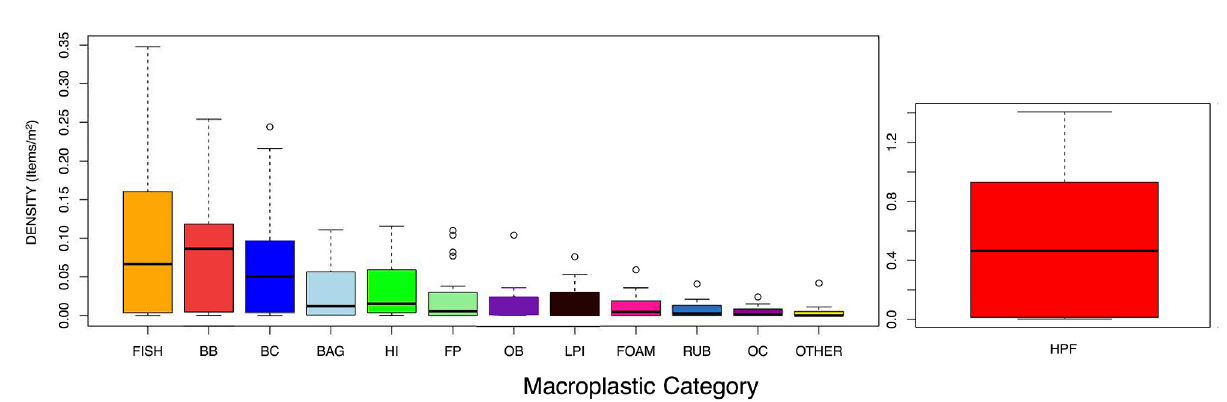
FIGURE2 Macroplastic category density (items/m 2 ) for all surveyed sites in the five bioregions. CSIRO categorization system (Schuyler et al., 2020) with adaptations. Categories are: HPF (Hard plastic fragments); FISH (Engine oil bottles, fishing buoys, fishing nets, monofilament fishing line, eel traps, plastic rope, string, twine); BB (Plastic beverage bottles); BC (Beverage bottle caps); BAG (Plastic bags); HI (Household items, razors, toothbrushes, deodorants, toys, straws, popsicle sticks, utensils, cutlery, food containers, tetra pack, plastic cups, plastic packing straps, shoes, sandals, balloon, cigarette, cloth item); FP (Film plastic food wrap, chip bags, “other” soft plastic); OB (Other bottles, i.e., shampoo, kitchen oil); LPI (Large plastic items, i.e., buckets, boxes, tubes ); FOAM (Any foam); RUB (Rubber gloves or other rubber items, i.e., tires.); OC (Other caps/lids); OTHER (Other items, i.e., glass, metal,